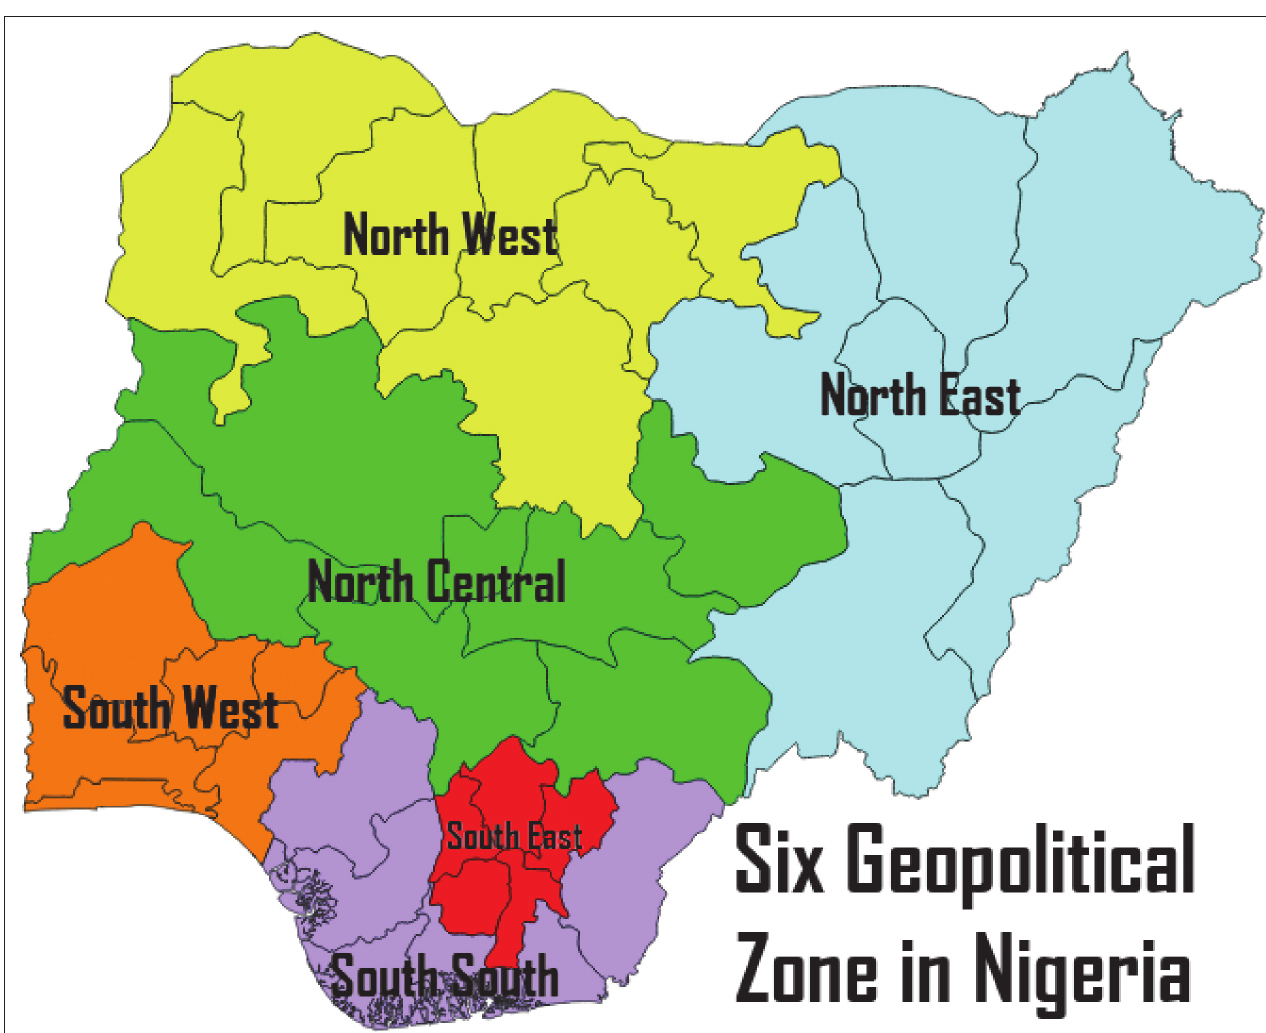
FIGURE 1-A1: Map of the six geopolitical zones in Nigeria.